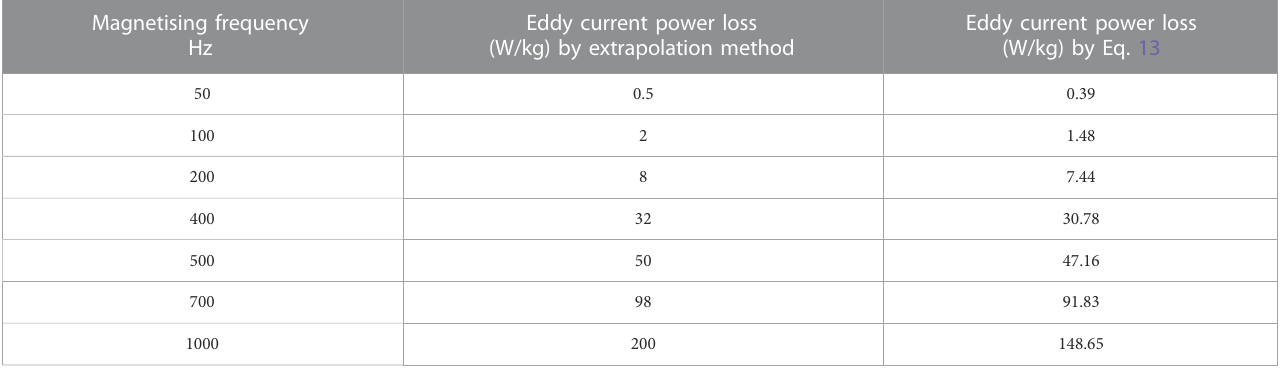
TABLE 8 Results obtained using by extrapolation method and the comparison of Eq. 13 was used to fi gure out the eddy current power loss of an SST with a peak fl ux density of 1.5 T and different frequencies. Magnetising frequency Hz